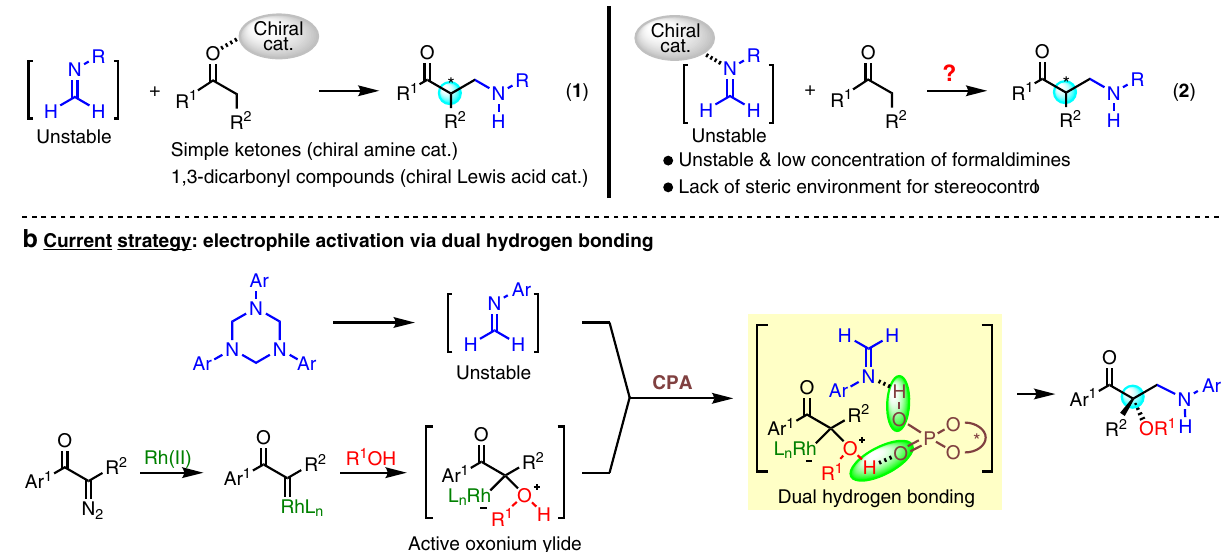
Fig. 1 Reaction design for aminomethylation with formaldimines. a Previous aminomethylation work of nucleophile activation mode. b Design of CPA dual hydrogen bonding directed electrophile activation mode multicomponent